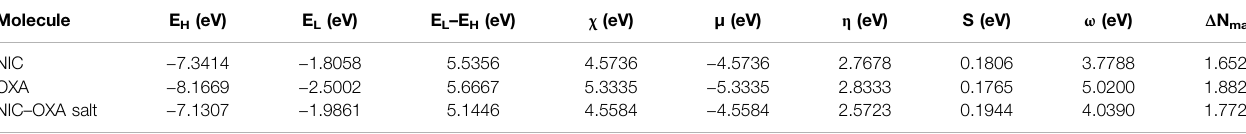
TABLE 3 | Calculated E HOMO , E LUMO , energy band gap (E L – E H ), chemical potential ( μ ), electro negativity ( χ ), global hardness ( η ), global softness (S), global electrophilicity index ( ω ), and maximum extent of charge transfer ( Δ N max ) at 298.15 K for nicotinamide (NIC), oxalic acid (OXA), and NIC – OXA salt using B3LYP/6-311++G(d,p).